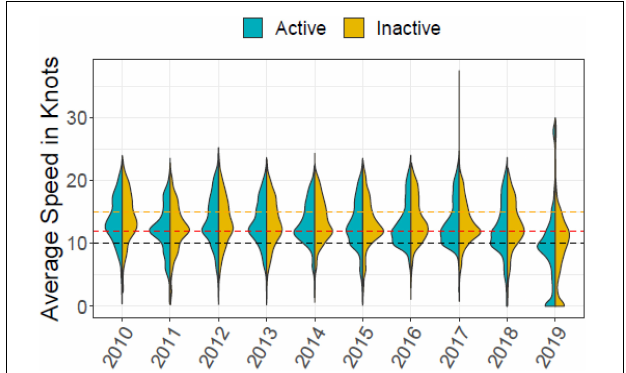
FIGURE 5 | Average speed of transits by vessels ≥ 300 GT, by year and by VSR status (active/inactive VSR time periods), 2010–2019. The width of the filled region of the plots is proportional to the number of transits. Black dotted line represents 10 knots, red line represents 12 knots, and yellow line represents 15